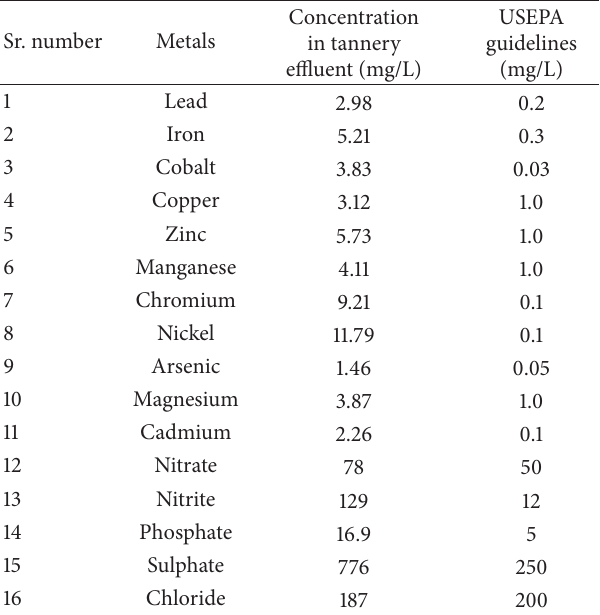
Table 2: Average concentration of metals and anions in the tannery effluent collected from Palar River (all values are mean range for three observations each).